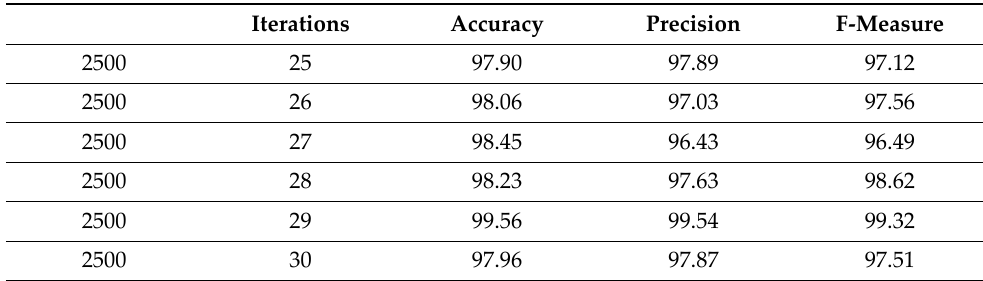
Table 11. PSO method results when utilizing a constant number of particles and an increasing num‑ ber of iterations.